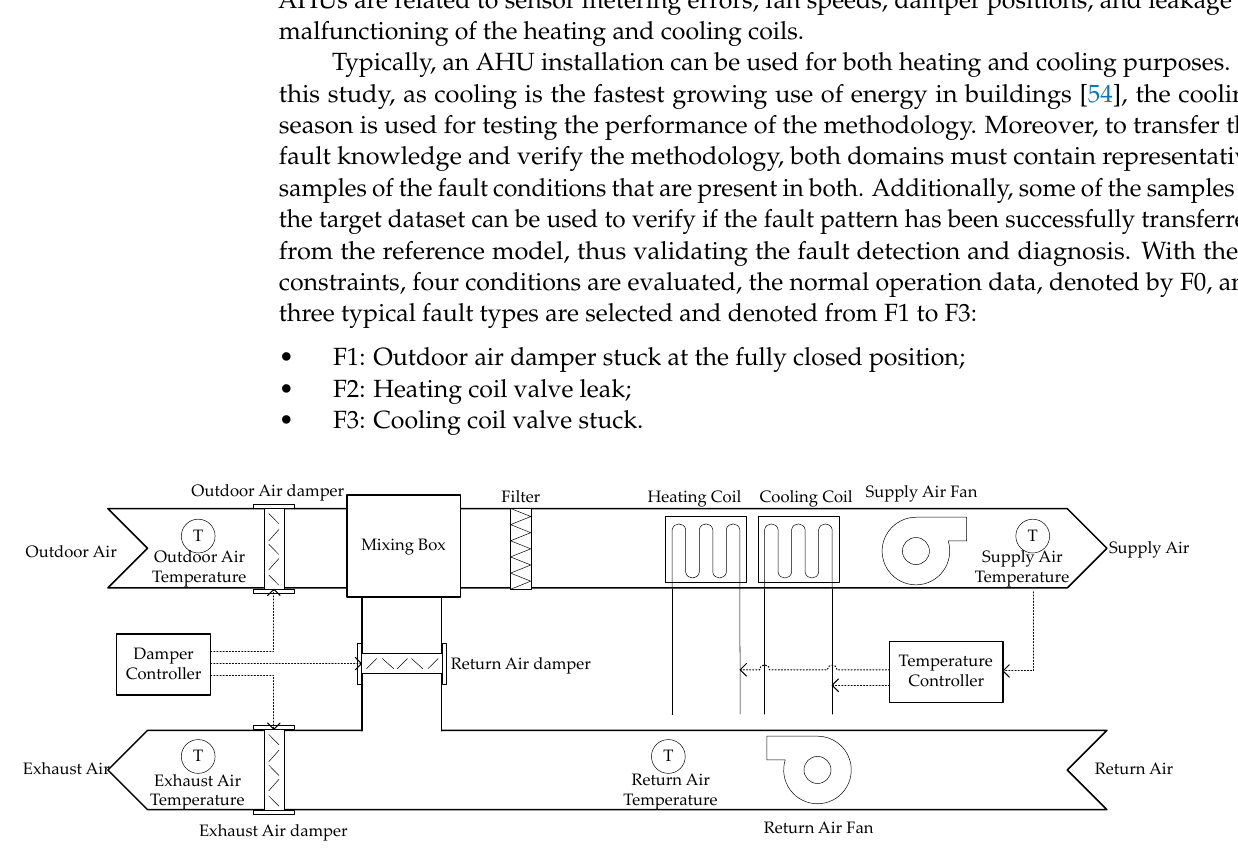
Figure 5. General scheme of an AHU installation including the supply air circuit with the correspond- ing heating/cooling coils and the mixing box, as well as the return air circuit. It must be noticed that both circuits, as well as their interconnection, are managed by the corresponding